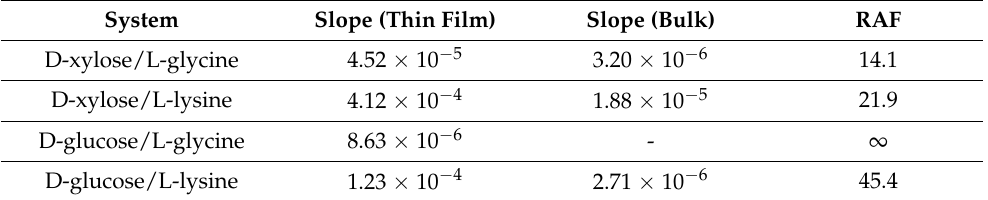
Table 1. The kinetic parameters and derived RAF for the investigated thin film and bulk reactions.